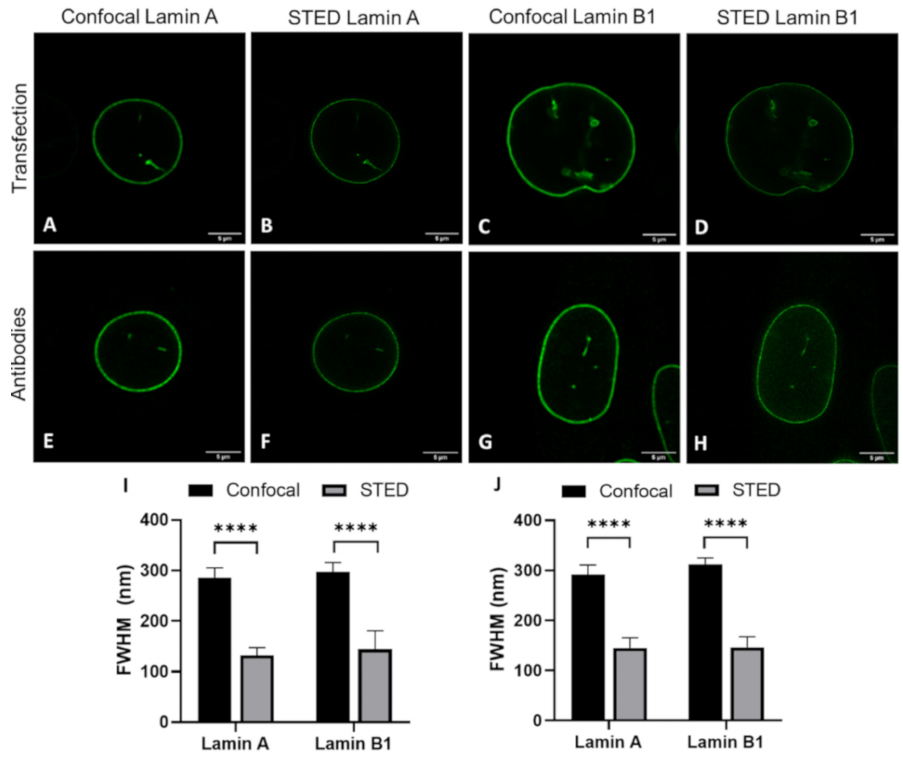
Figure 3. Comparison of confocal ( A , C , E , G ) and STED ( B , D , F , H ) microscopy images. ( A , B ) 3T3 lamin-A-YFP transfected. ( C , D ) 3T3 lamin-B1-EGFP transfected. ( E , F ) 3T3 cells stained with anti- bodies against lamin A. ( G , H ) 3T3 cells stained with antibodies against lamin B1. Scale bars: 5 µ m. ( I , J ) Average FWHM (nm) of confocal and STED microscopy images of ( I ) transfected 3T3 cells and ( J ) antibody-stained 3T3 cells. Bars, mean ± SD. **** p ≤ 0.0001. Table 1. Average STED and confocal microscopy FWHM ± SD (nm) as a measure of the lamin layer thickness of lamin A(/C) and B1 in transfected 3T3 cells, 3T3 cells stained with antibodies, and nHDF stained with antibodies, both in separate transfection or immunostaining and co-transfection or co-staining. The layer thickness was determined at five different positions in each